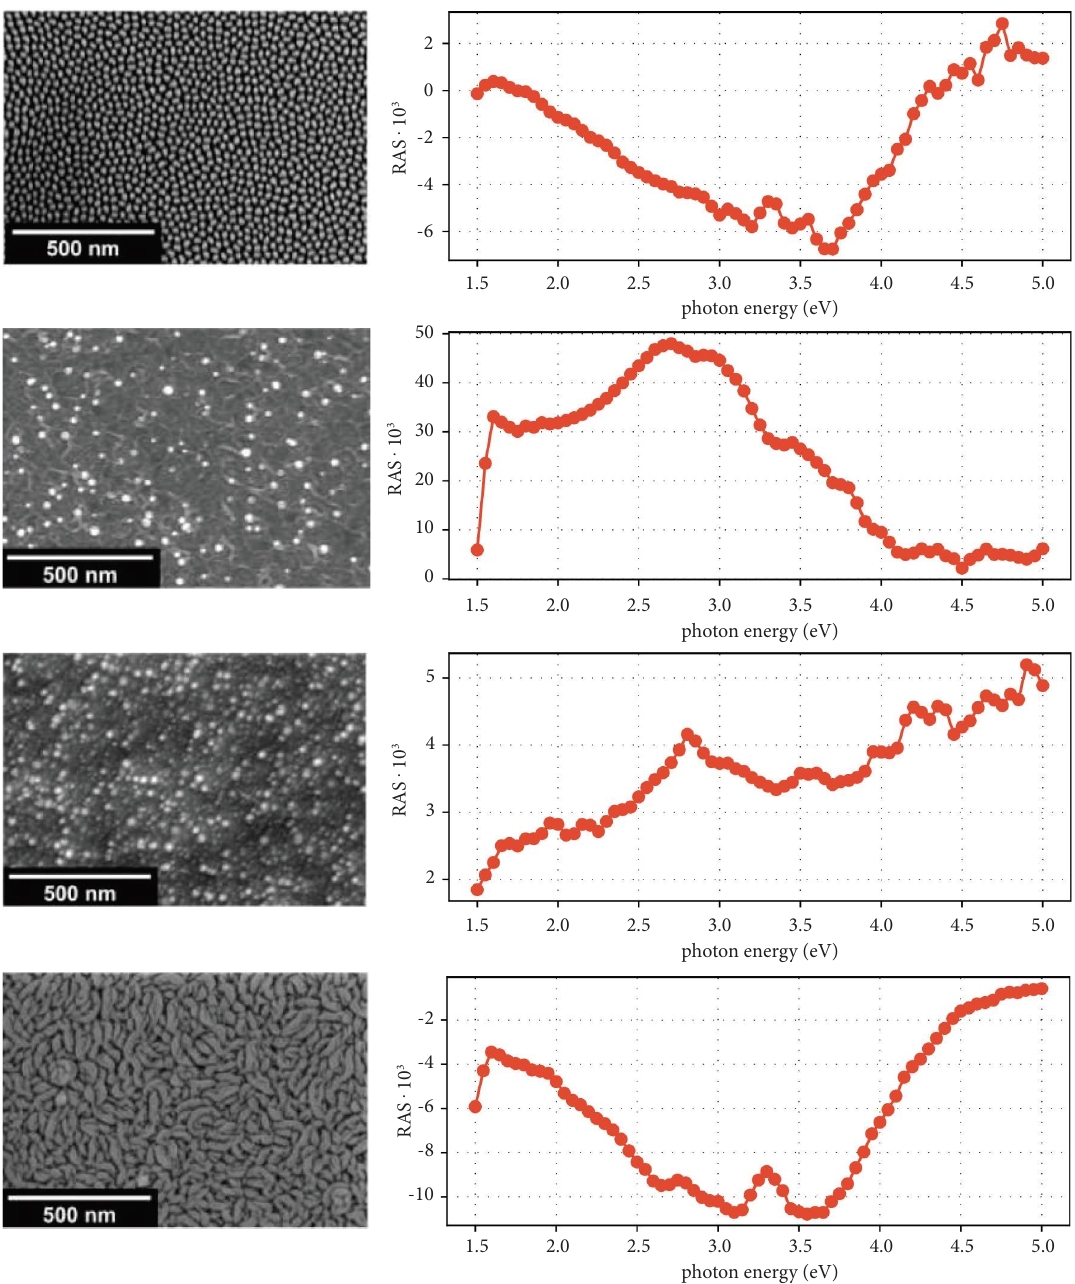
Figure 1: For four samples scanning electron microscope (SEM) images: (a) and related genuine RAS signal spectra. (b) Te top two experimental results correspond to etching of plain GaSb wafers, the bottom ones to plain GaAs